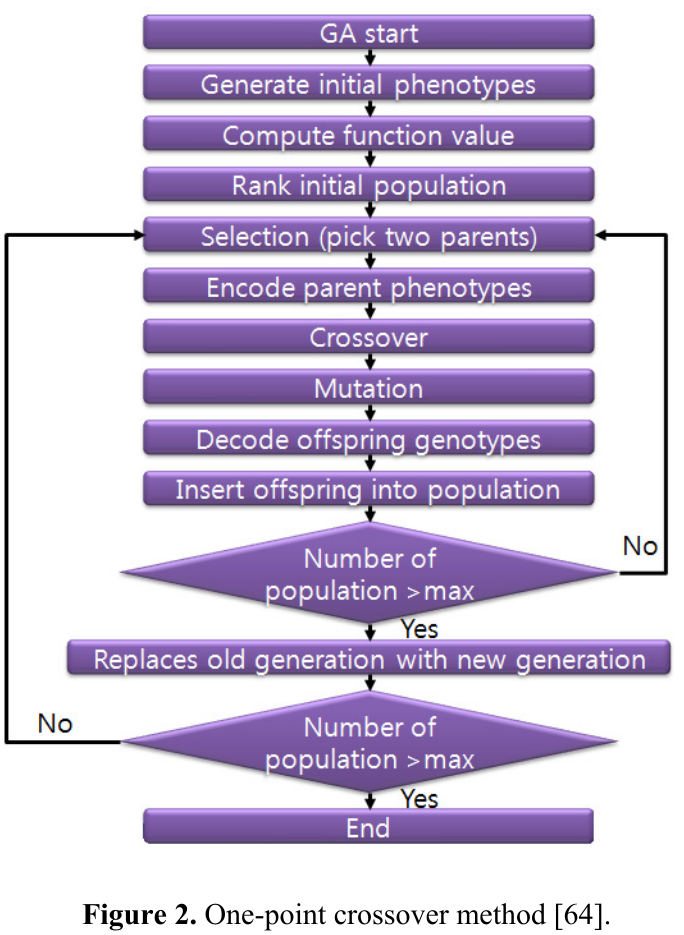
Figure 1. Flow chart of GA PIKAIA technique.